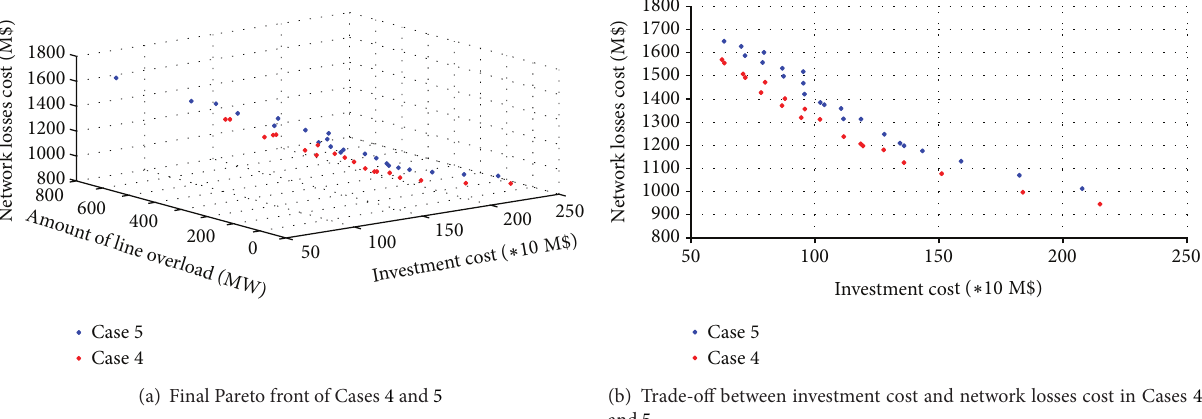
Figure 5: Final results of Cases 2 and 3.